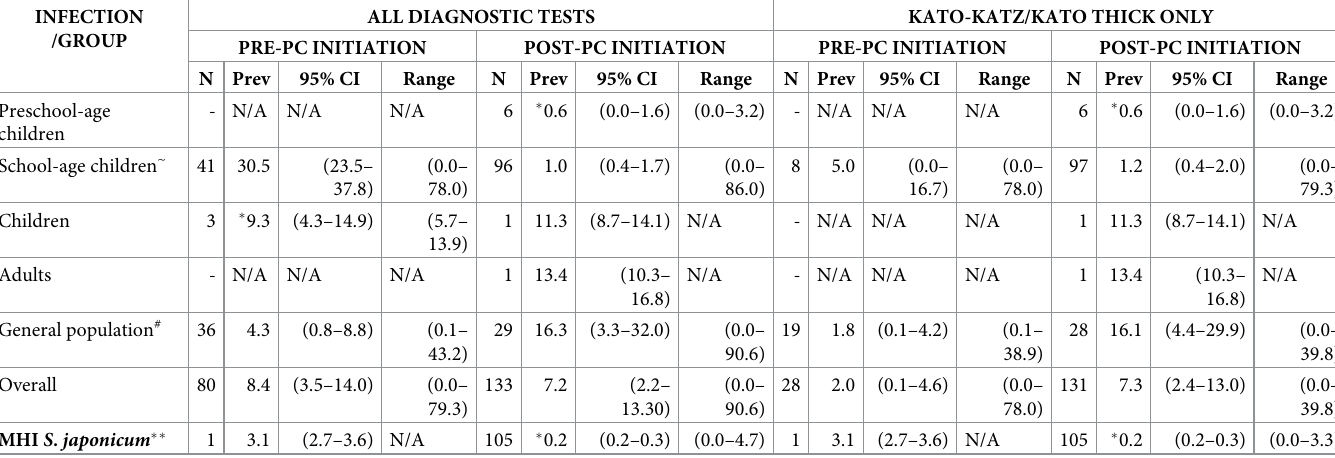
Table 5. Meta-analyses of prevalence of Schistosoma japonicum by preventive chemotherapy status and population group (1954–2018).